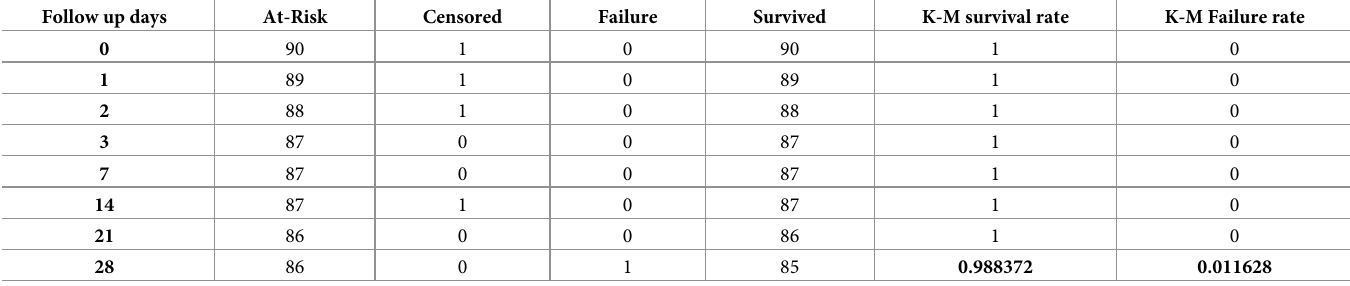
Table 3. Chloroquine treatment outcome of study participants based on K-M analysis in Shewa Robit Health Center, northeast Ethiopia from November 2020 to March 2021. Follow up